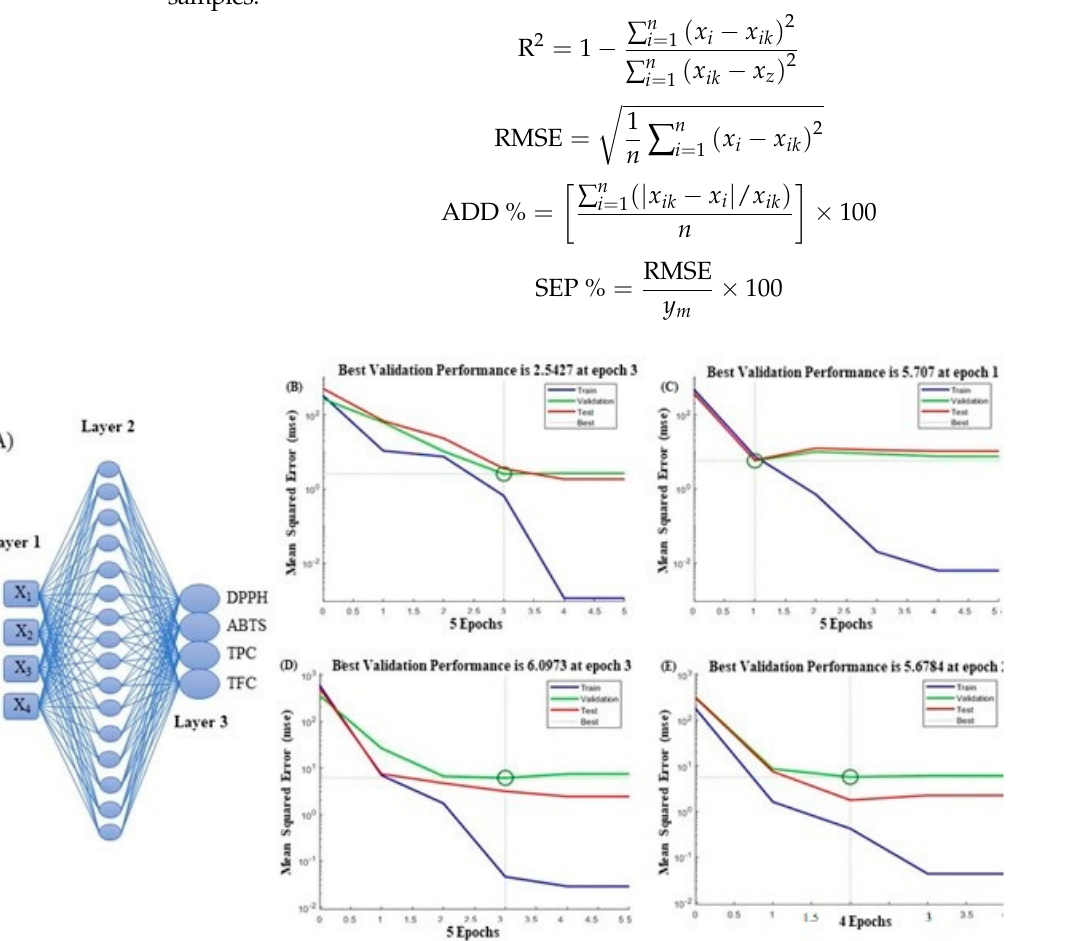
Figure 1. Optimal topology of optimized MAE-assisted SF extracts. Best architecture of a developed MAE-ANN model with the lowest mean square error (MSE) ( A ); The results of Levenberg-Mar- quardt algorithm with optimum numbers of neurons for best validation performance compared with training, testing and validation data for dependent variables DPPH ( B ) ABTS ( C ), TPC ( D ), and TFC ( E ), and comparison among experiment run (*), RSM (blue line), and ANN (red line) for DPPH ( F ), ABTS ( G ), TPC ( H ), and TFC ( I ) using deep learning toolbox MATLAB software.